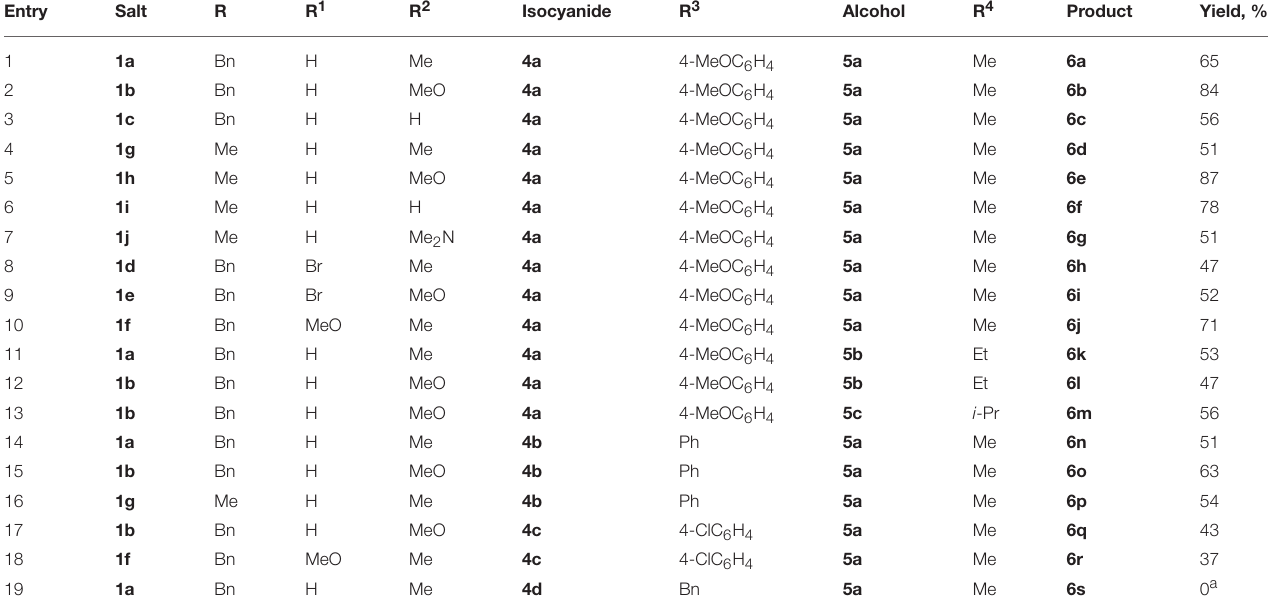
TABLE 2 | Synthesis of imidates 6 .